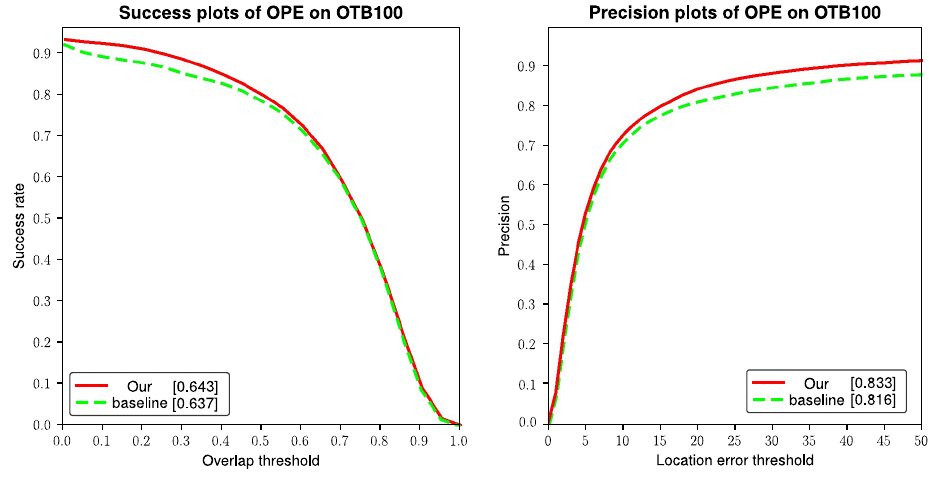
Figure 5. The ablation studies on the OTB-100